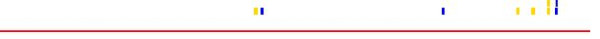
Schematics of zinc finger arrays binding to HPV type 16 E6 gene. This figure offers a diagrammatic illustration of loci of action of zinc finger arrays that specifically bind to 9 bp nucleotide sequences within the DNA context of the HPV type 16 transforming gene, E6. Hits (blue, green, and gold bars) represent targets along the gene (red bars). ZFA hits in the graphic are color-coded on the basis of spacer size (5 bp = Blue; 6 bp = Green; 7 bp = Gold).